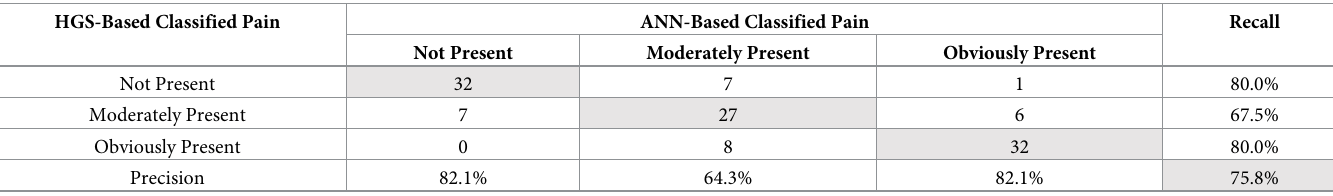
Table 7. Confusion matrix between the data classified by the ANN-based classifier and HGS, described on three levels of pain. HGS-Based Classified